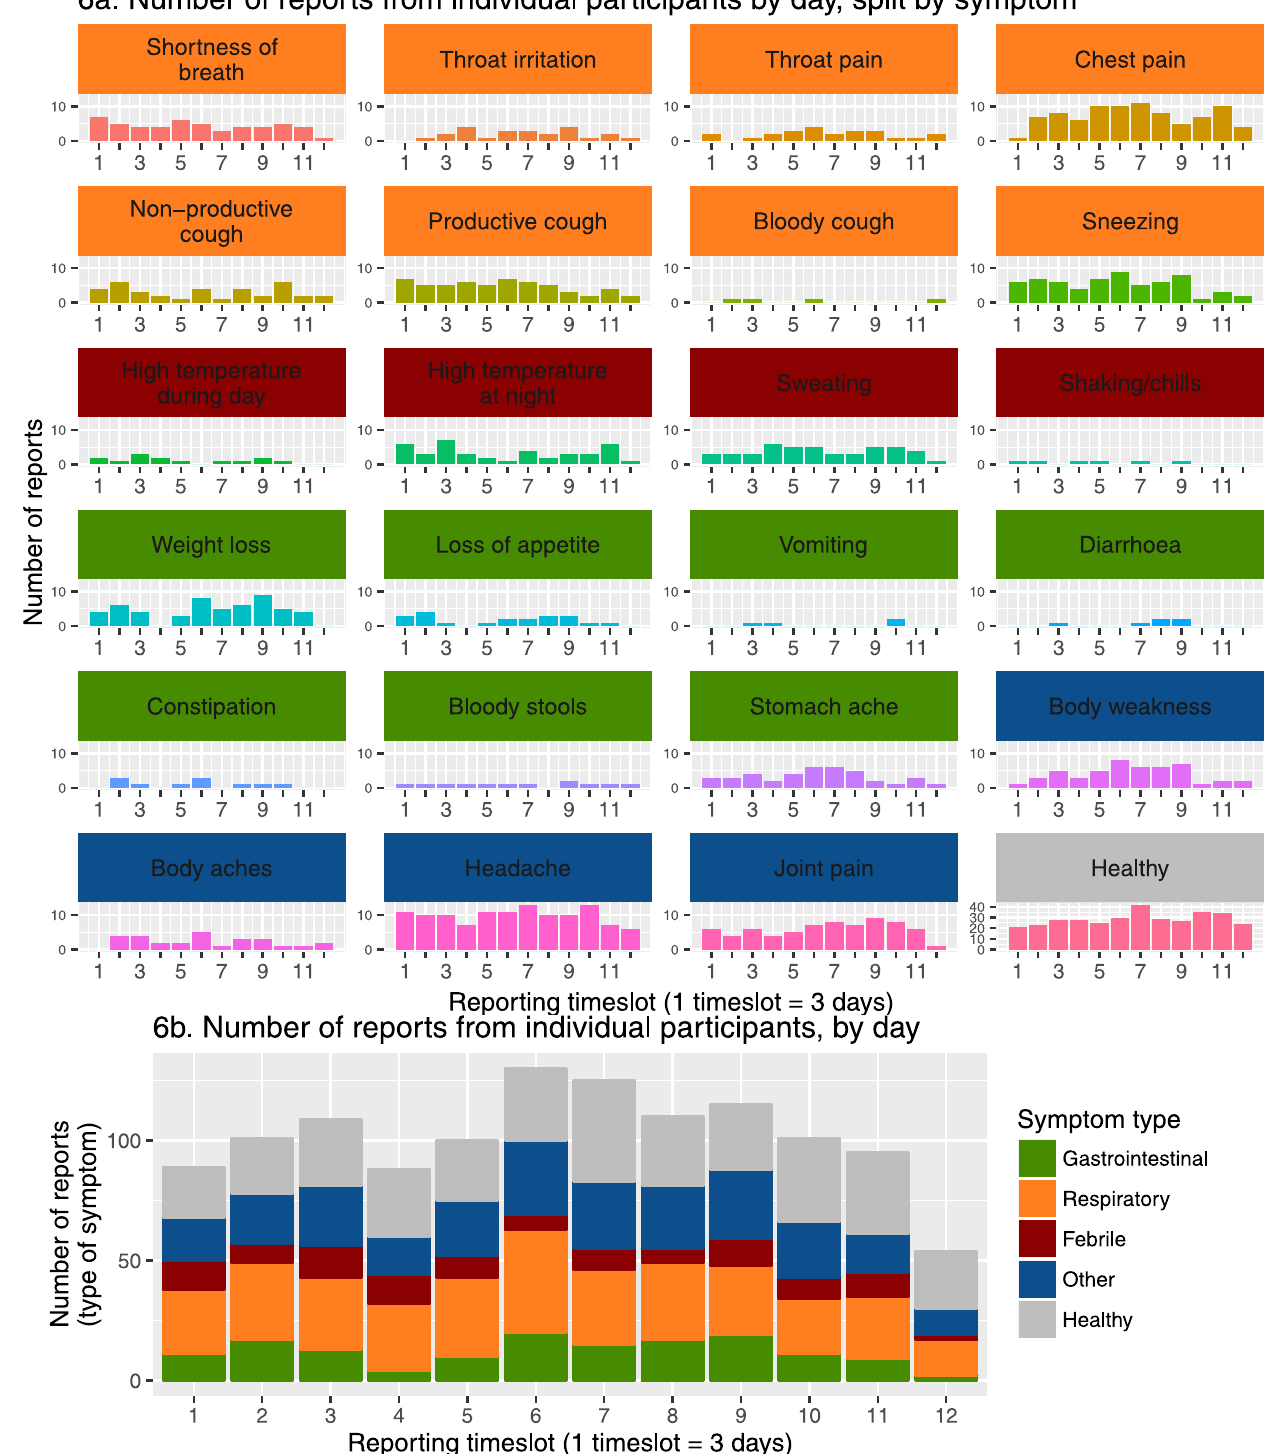
Fig 6. Symptom report totals by timeslot. Mentions of individual symptoms in reports by timeslot( 6a ), total symptom reports of a given type by timeslot ( 6b ).